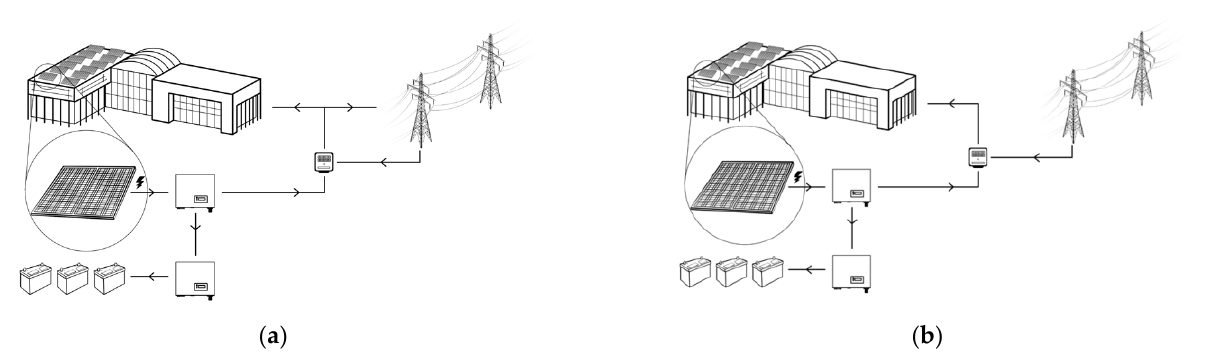
Figure 5. System components and topology in the cases: without grid injection restriction ( a ) and with zero-injection restrictions ( b ).